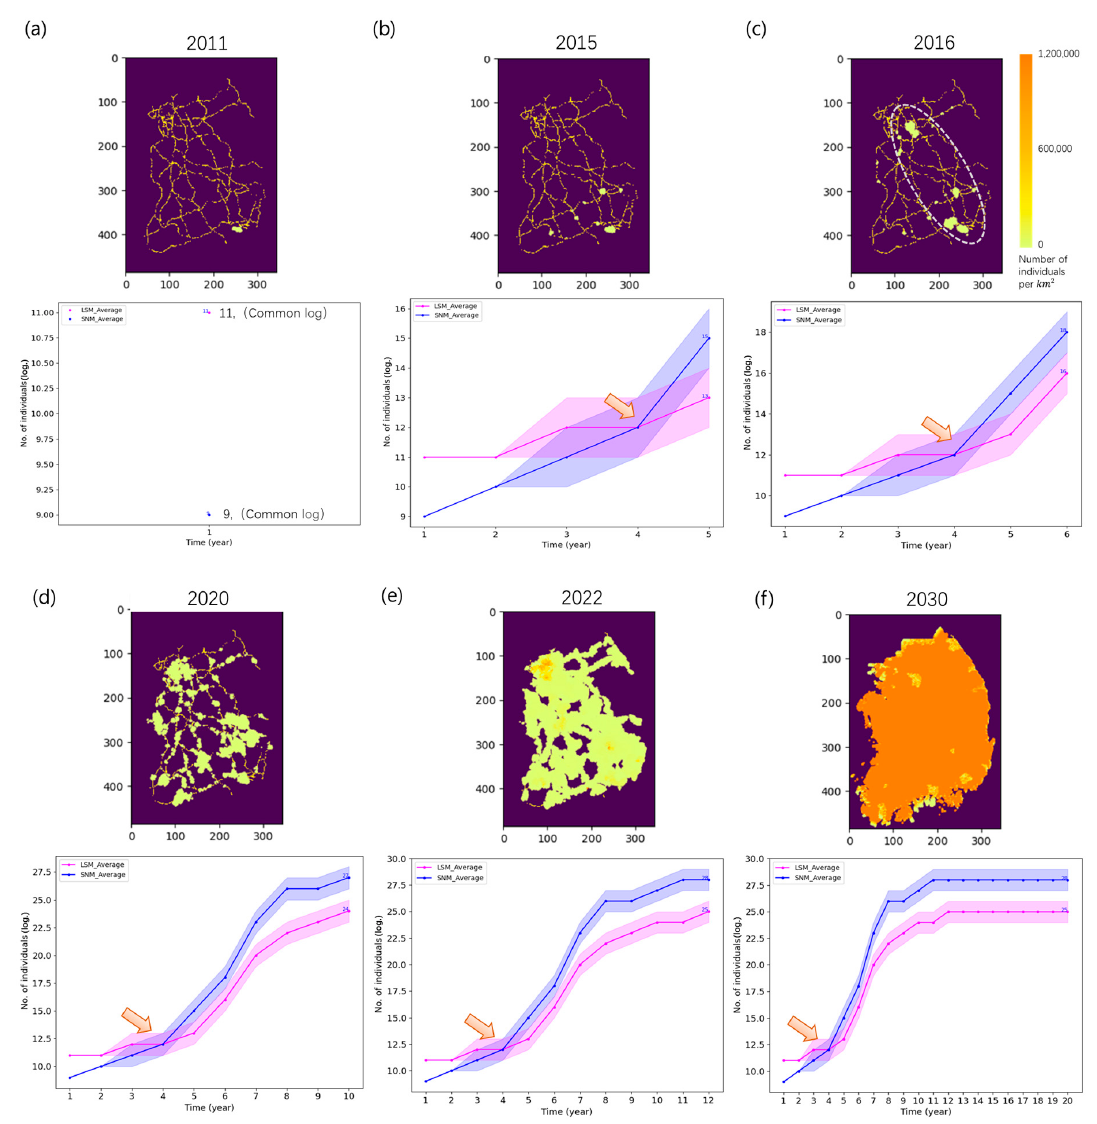
Figure 7. Simulating advancement patterns of WCSB populations between 2011–2030 in the southern Korean peninsula starting from 2010 according to LSM and SNM (Allee threshold; 1000 individuals/km 2 , Gamma; 0.25) for the years of 2011 ( a ), 2015 ( b ), 2016 ( c ), 2020 ( d ), 2022 ( e ), and 2030 ( f ). In each subfigure top panel indicates spatial map and bottom panel presents increase in the total number of individuals (log.) during the simulation period. Horizontal and vertical units in two-dimensional maps in the top panel are expressed in km for convenience of illustration. Arrows in the bottom panel indicating the points where the population size obtained by SNM surpasses the population size obtained by LSM.